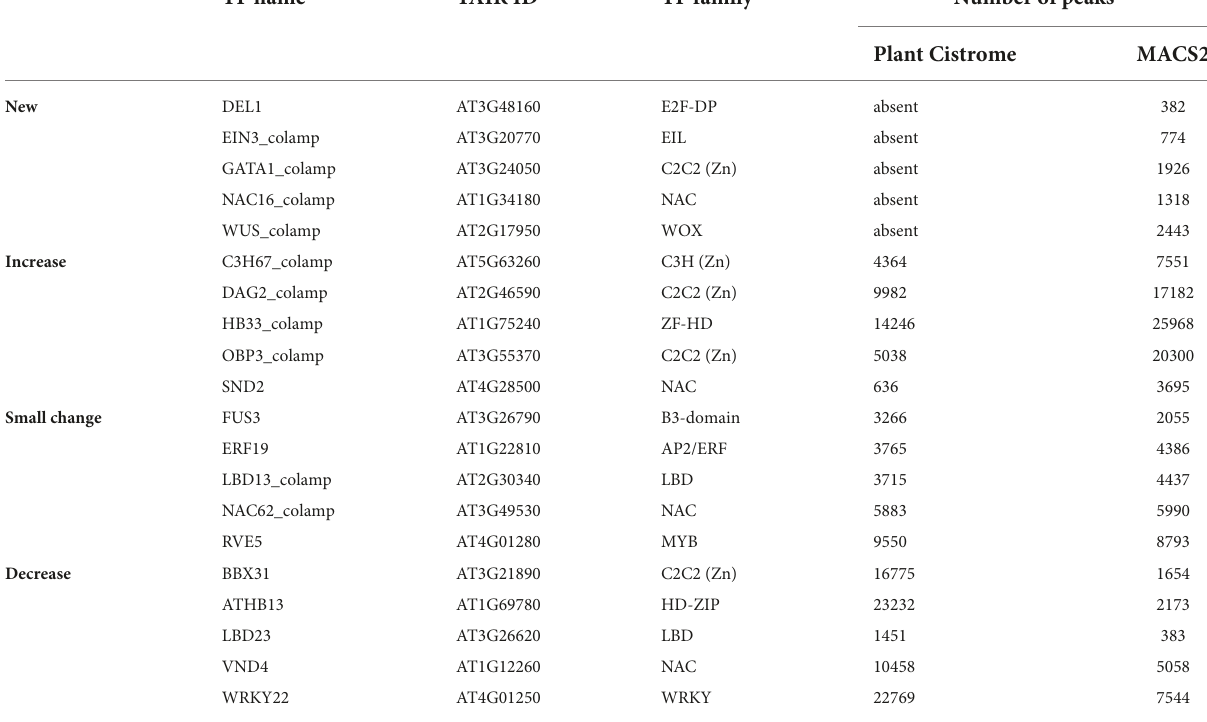
TABLE 1 Changes in the number of peaks between selected TF binding profiles from the CisCross-MACS2 and Plant Cistrome versions of the DAP-seq peak set